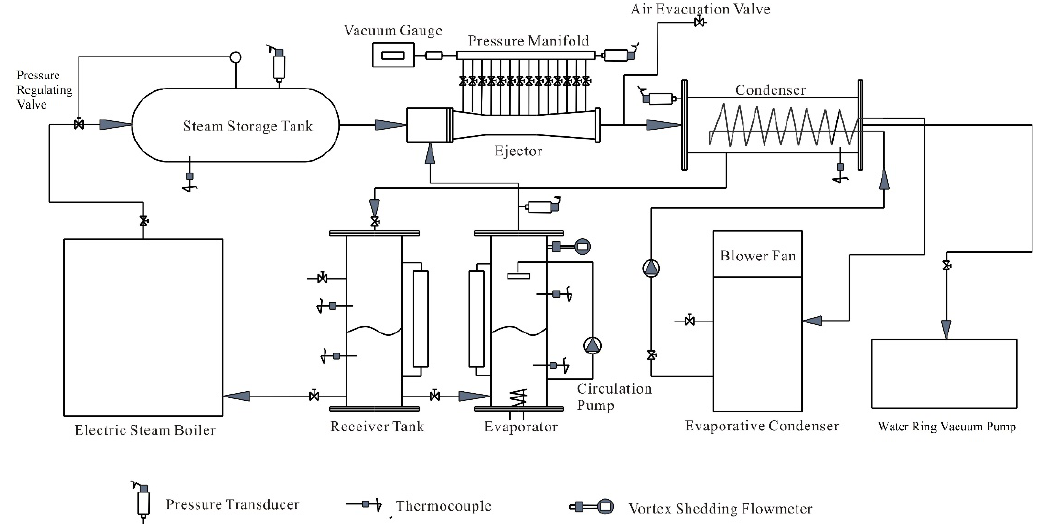
Figure 1. The experimental steam ejector refrigeration system.